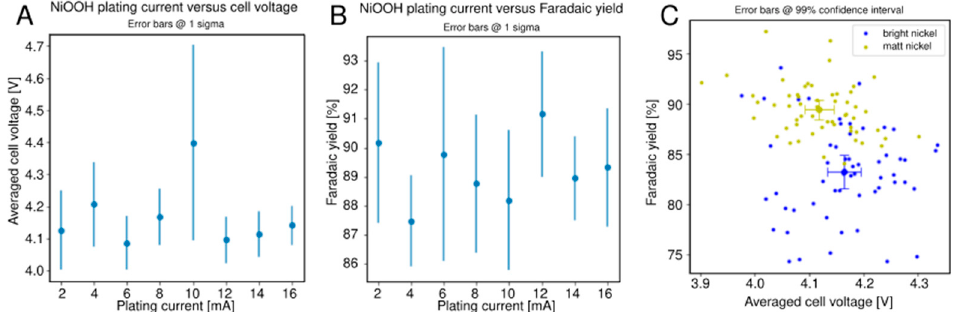
Figure 7. The effect of plating current on cell voltage ( A ) and Faradaic yield ( B ) (8-point average and standard deviation). ( C ) Comparison between the Ni(O)OH material and the base bright nickel material (excluding outliers in “column” 3).